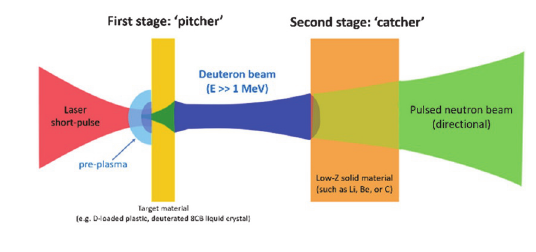
Fig. 1. Schematic of the principle of laser-driven neutron sources, see text for